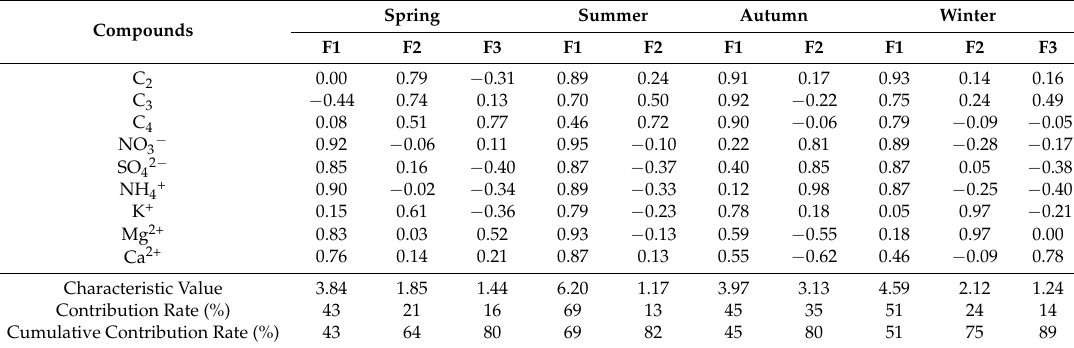
Table 3. Results of principal component analysis of diacids and selected water-soluble inorganic ions in the PM 10 aerosols of Huangshi, Central